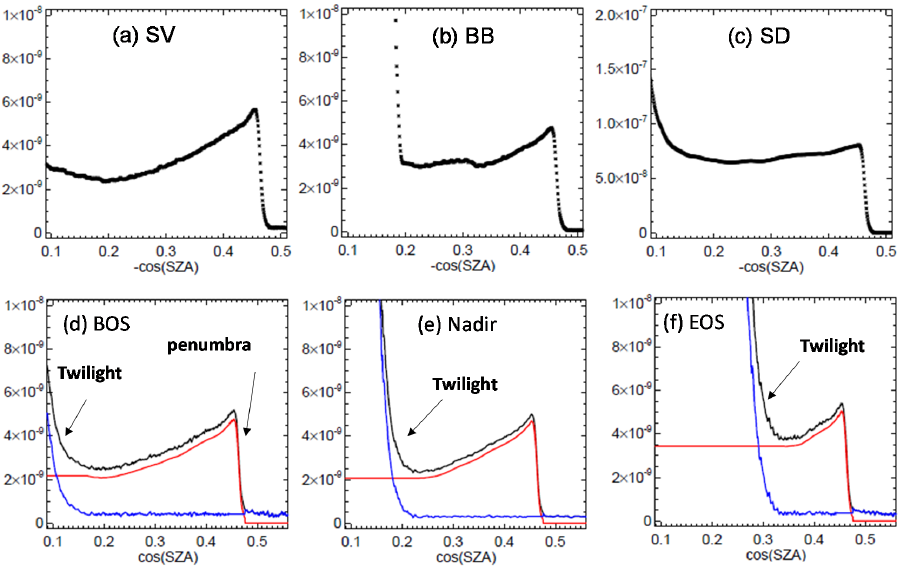
Figure 4. DNB detector 8 EV and calibration view dark signals near northern hemisphere stray light problem regions on October 5, 2013. ( a – c ) show calibration views. EV dark signals for beginning of scan (BOS), nadir, and end of scan (EOS) are shown in ( d ), ( e ), and ( f ), respectively. Black curves: dark signals; red curves: estimated stray light; blue curves: signals after stray light correction. SZA = solar zenith angle.